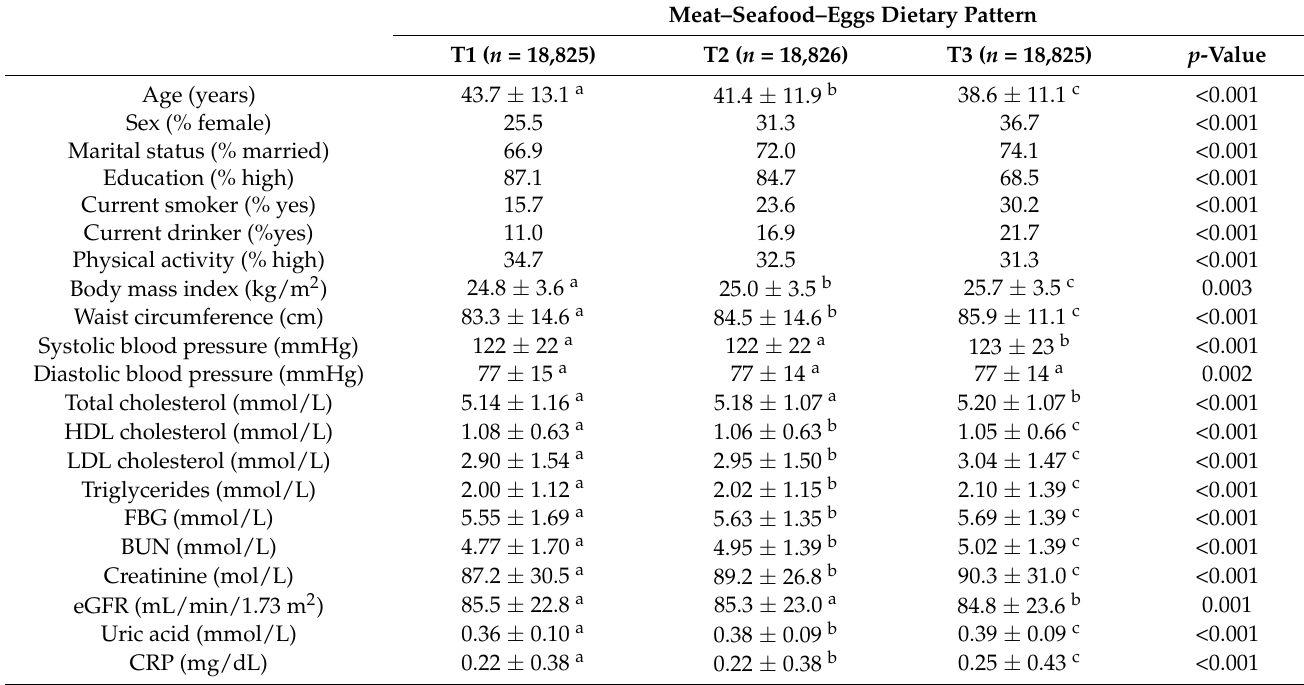
Table 5. Characteristics of the subjects across tertiles of the meat–seafood–eggs dietary pattern ( n = 56,476) 1 . Meat–Seafood–Eggs Dietary Pattern